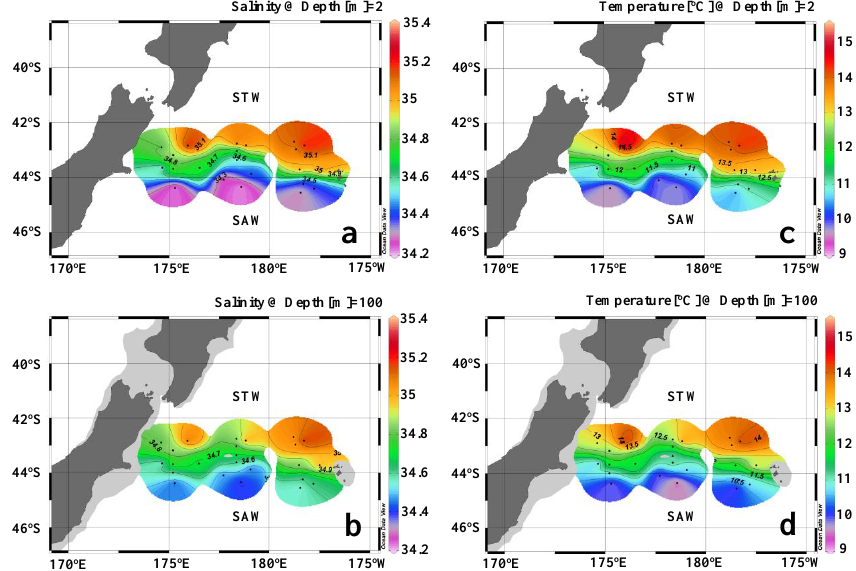
Fig. 3. Distributions of temperature and salinity, highlighting dramatic changes within the Subtropical Frontal zone: (a) surface salinity at 2m water depth, (b) salinity at 100m, (c) surface temperature, and (d) temperature at 100m. The Subtropical water (STW) and Subantarctic water (SAW) are also